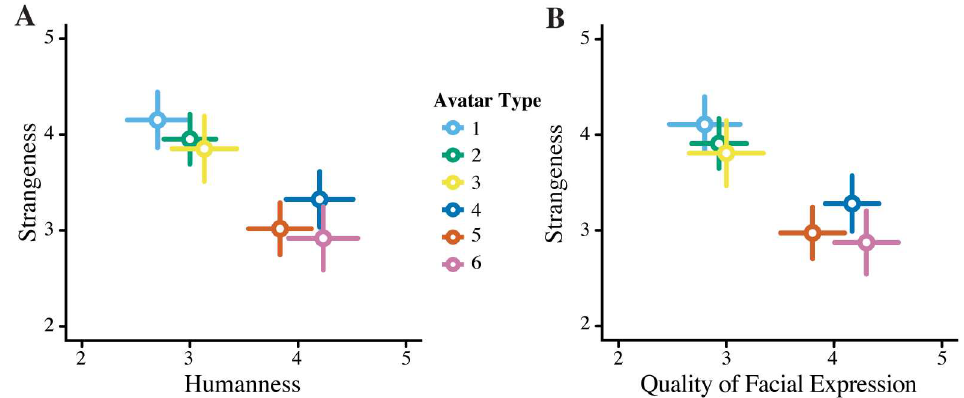
Fig 2. Rating of AvatarVersions for Experiment 1. A. Correlationbetweenthe strangeness and humanness ratings, and B. Correlationbetweenthe strangeness and quality of facial expressions for the six avatars. Error bars represent standard